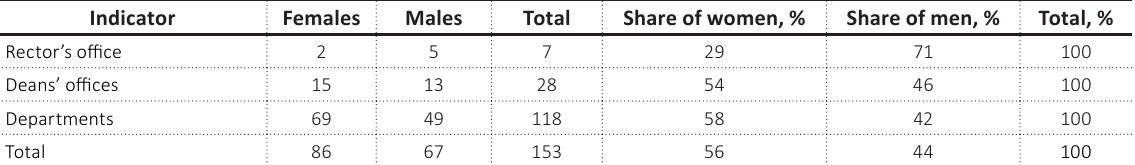
Table 3. Gender dimension of management of deans’ offices at